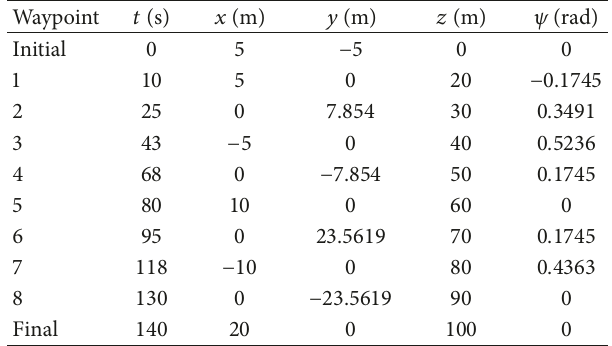
Table 6: Waypoints configuration with their scheduled flight time- table.